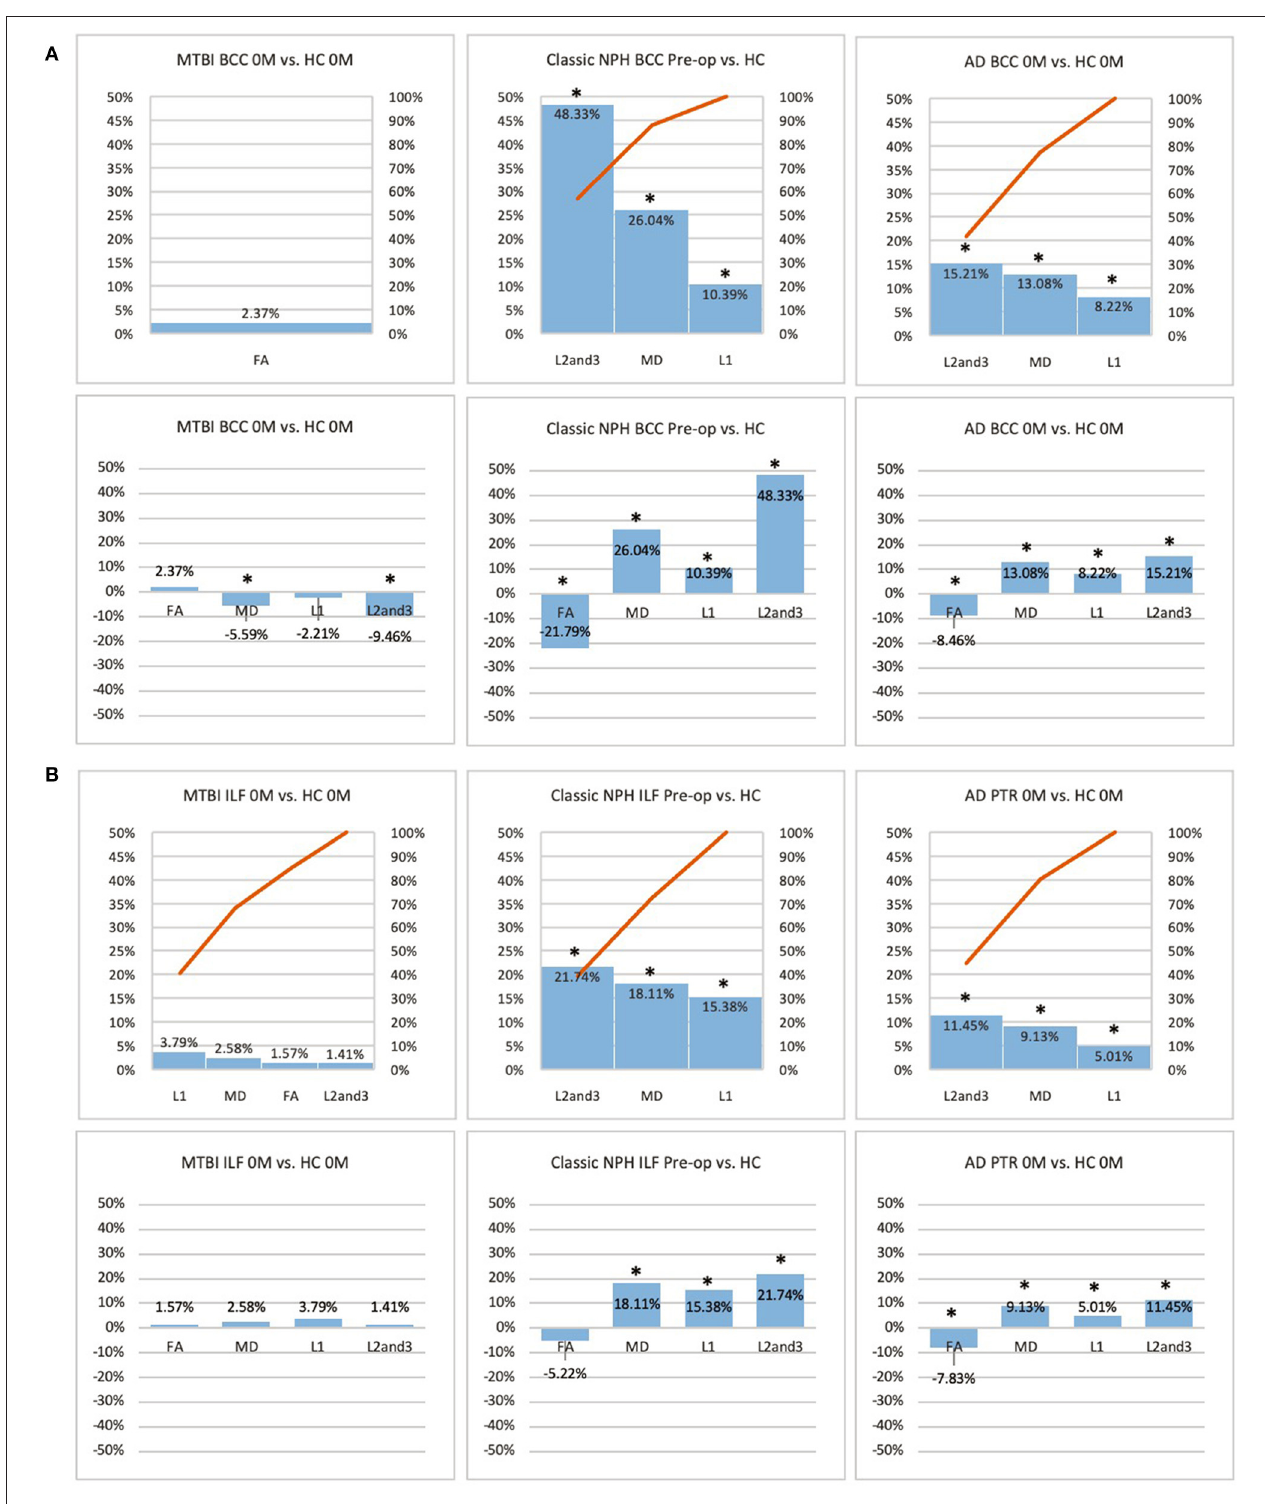
FIGURE 3 | (A) Midline (BCC) and (B) lateral (ILF or PTR) ROI families at baseline. At baseline, percentage differences in DTI measures of clinical cohorts are compared against corresponding healthy controls, presented as Pareto graphs and bar charts. In Pareto graphs, positive values are automatically arranged sequentially, in order of highest to lowest magnitude of differences/changes. *Indicates a significant Difference between the clinical cohort and healthy controls at p < 0.05.